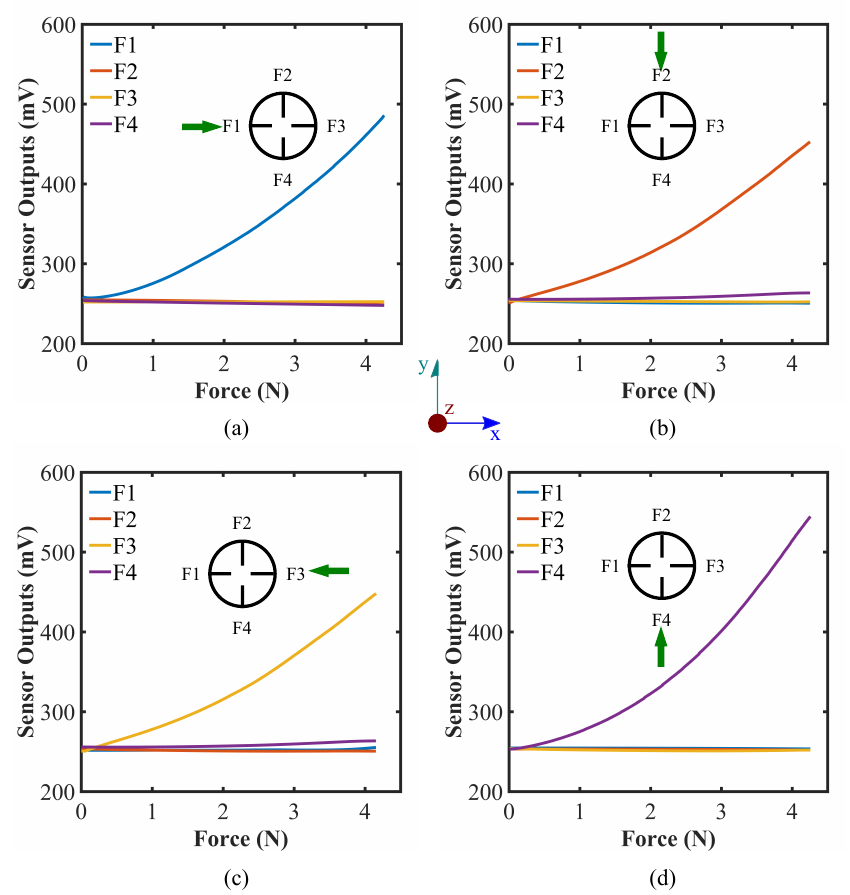
Figure 5. Force calibration against forces on the sides (specifically on the inserted flex sensors) of the hemispherical sensor (at 30 ◦ latitude), along ( a ) x-axis, ( b ) -y-axis, ( c ) -x-axis, and ( d ) y-axis; top view of the sensor system is illustrated and the green arrow depicts the applied force